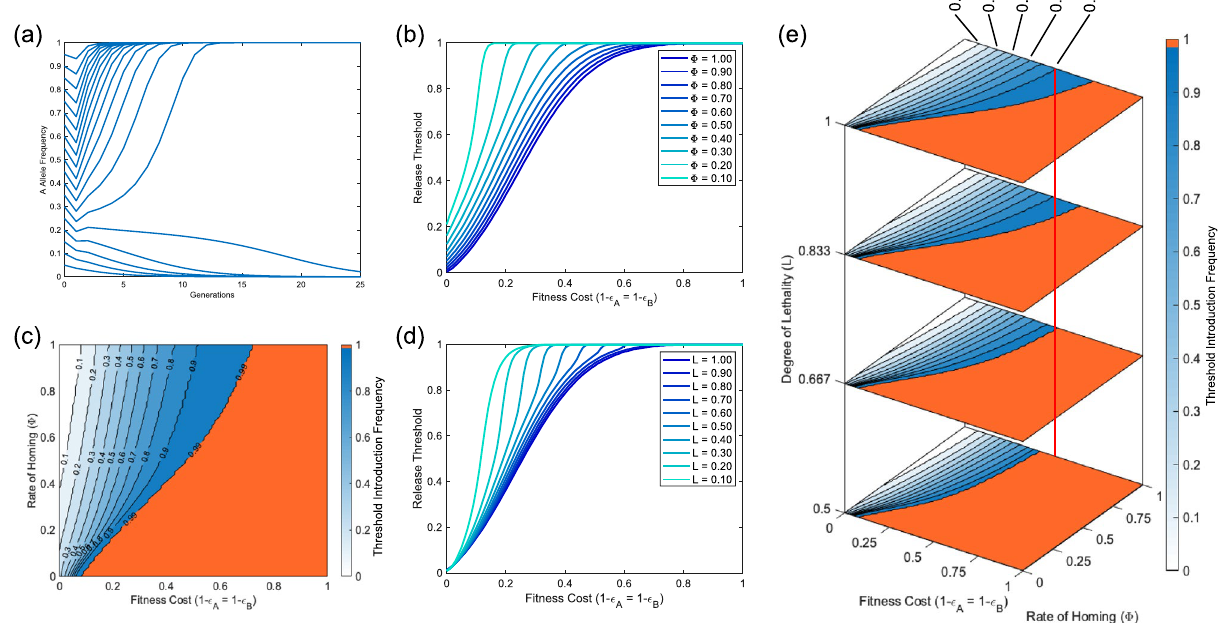
Figure 4. SDKR displays threshold dependent behaviour that is affected by a range of parameters. Panel ( a ) shows sample numerical simulations demonstrating threshold-dependence of SDKR (with homing rate (cid:31) = 0.9 , relative fitness ε = 0.85 and lethal penetrance L = 1 ). Panel ( b ) demonstrates how the introduction threshold required for the system to spread (shown on the vertical axes) changes with variation in the rate of homing ( (cid:31) ) and relative fitness ( ε ) parameters with L = 1 . Similarly, ( c ) demonstrates the effect on required release thresholds but over the full range of possible homing rates ( (cid:31) ) with L = 1 . Here an orange area denotes the parameter space in which the system gives a threshold introduction frequency ≥ 0.99 (i.e. where the system is unable to increase in frequency). Panel ( d ) demonstrates the effect of variation in relative fitness ( ε ) and the degree of lethality conferred by the lethal effector from construct A—with homing rate (cid:31) = 0.9 . Finally, panel ( e ) shows how initial release thresholds are affected over the full range of relative fitness ( ε ) and homing rate ( (cid:31) ) parameters as well as a selection of lethal penetrance parameters ( L ). Here the red line is included to aid visual distinction between the locations of contour lines. As in ( c ), here an orange area denotes parameter space where the system is unable to increase in frequency. Note that in each case we consider the release of individuals homozygous for both transgenic constructs and fitness costs that are applied